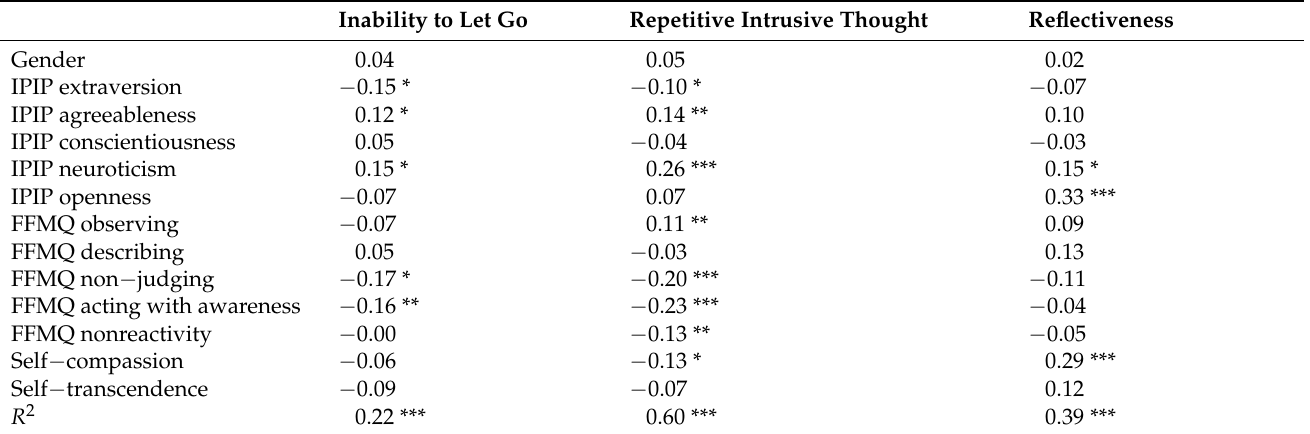
Table 6. Results from multiple regression analyses predicting the inability to let go, repetitive intrusive thought, and reflectiveness from gender, the Big Five, and the mindfulness variables in Sample 2. All regression coefficients are beta coefficients (i.e., standardized